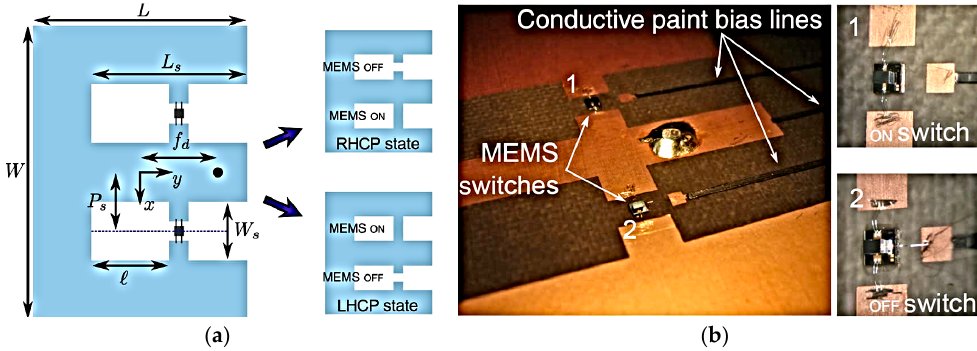
Figure 4. ( a ) Configuration of the micro-electromechanical system (MEMS) reconfigurable antenna and ( b ) magnified view of the switch implementation (redrawn from [38]).